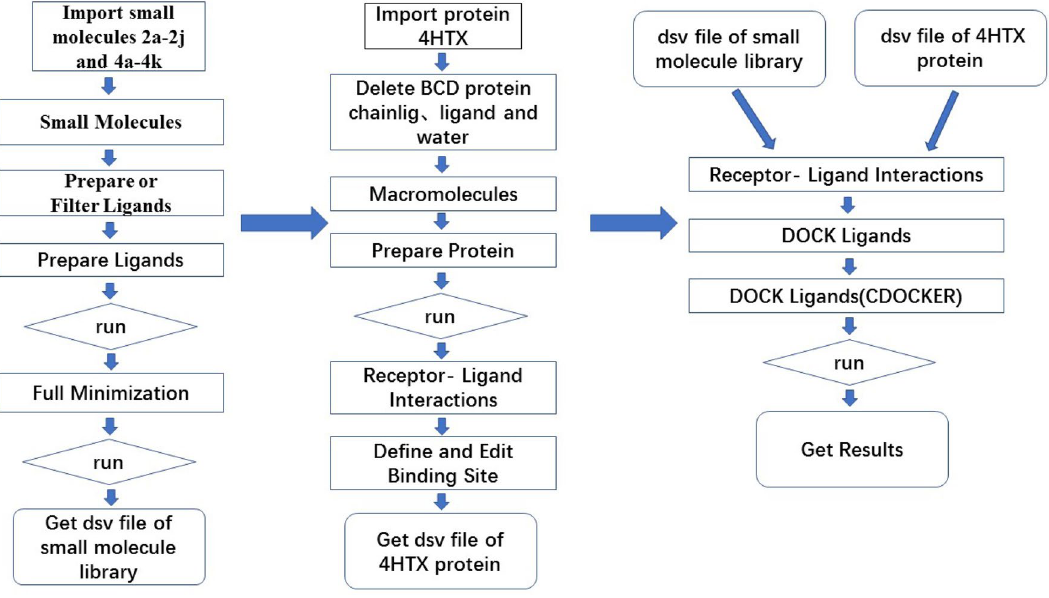
Figure 4. Molecular docking program of discovery